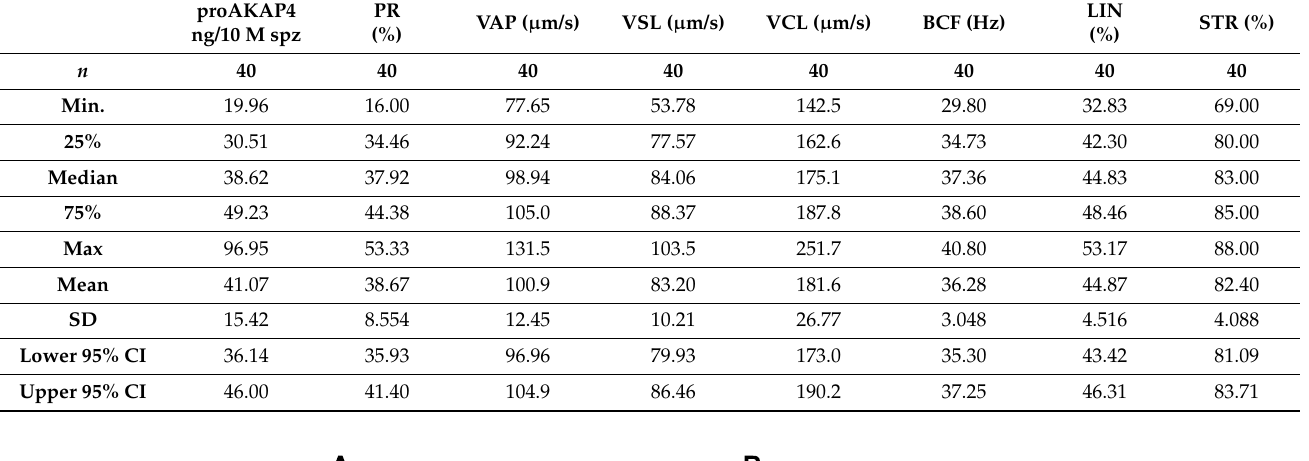
Table 1. Descriptive statistics of proAKAP4 values and all motility descriptors. Minimum and maximum values (min. and max.), the 25, 75 percentile and median, the mean and standard deviation (SD), as well as the lower and upper 95% confidence intervals (CI). ProAKAP4 ng/10 million of spermatozoa (ng/10 M spz), Progressive motility (PR), average path velocity (VAP), straight line velocity (VSL), curvilinear velocity (VCL), beat cross frequency (BCF), linearity (LIN), and straightness (STR).